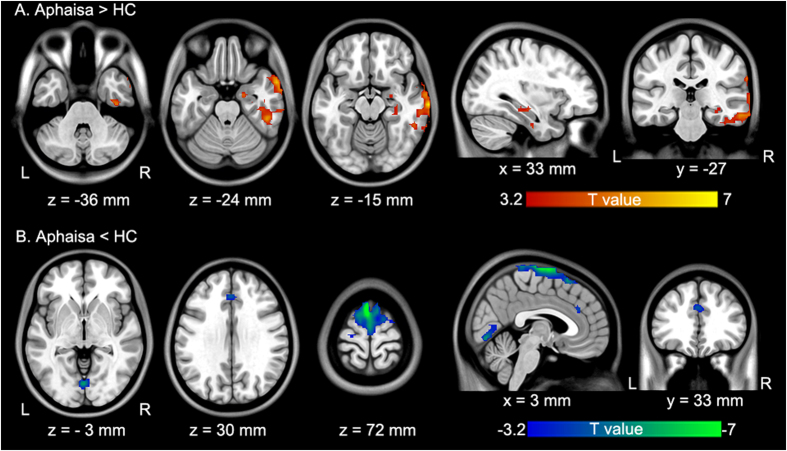
Brain regions showing significant differences in ALFF between aphasic patients and controls.All comparisons were performed using a two-sample t-test (p < 0.05 FDR-corrected and minimum cluster size of 30 voxels). (A) Warm colors indicate regions with increased ALFF values in aphasia. (B) Cold colors indicate regions with decreased ALFF values in aphasia. Numbers below each sagittal, coronal and axial slice refer to the x-, y-, and z-plane coordinates of the MNI space, respectively. Letters L and R correspond to the left and right sides of the brain, respectively. Further details of these regions are presented in Table 3.